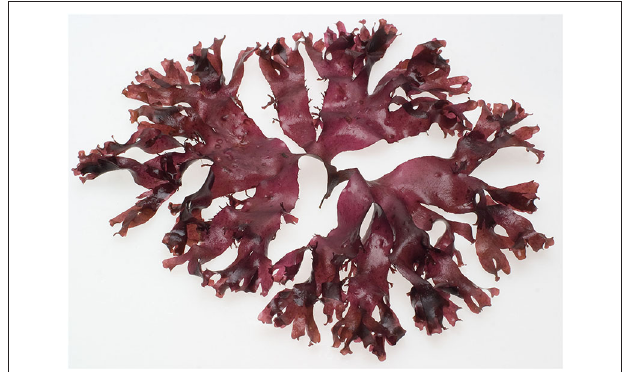
FIGURE 1 | An edible seaweed, dulse ( Palmaria palmata ), a delectable seaweed with a considerable umami potential (Permission to reprint by Jonas Drotner Mouritsen).